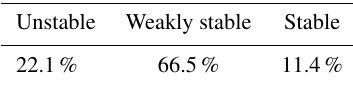
Table 1. Distribution of atmospheric stability based on the bulk Richardson number Ri b , where Ri b < 0 indicates unstable condi- tions, 0 ≤ Ri b ≤ 0.25 implies weakly stable conditions, and Ri b > 0.25 indicates stable